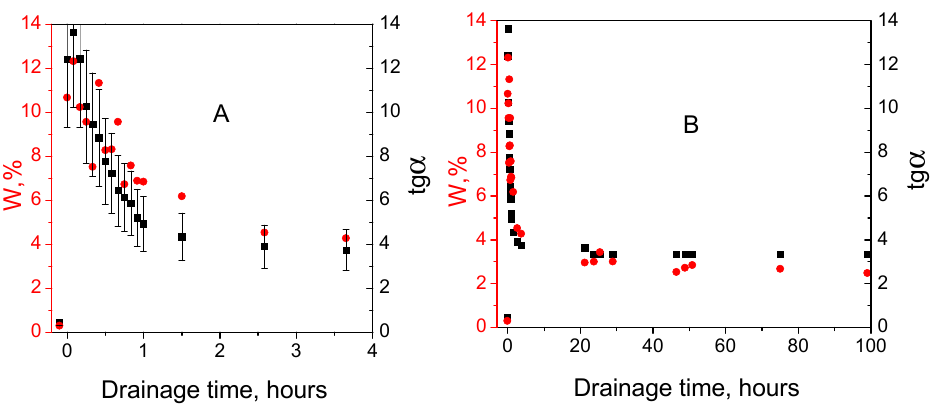
Figure 13. Dependence of moisture ( W , %—red circles • ) and tangent of the slope angle of the relative reflectivity graph (tan α —black squares ■ ) on the time of water drainage on a narrow ( A ) and wide ( B ) time intervals. The vertical bars indicate errors of ±20%. Note that relative reflectivity is proportional to the amplitude of the reflected